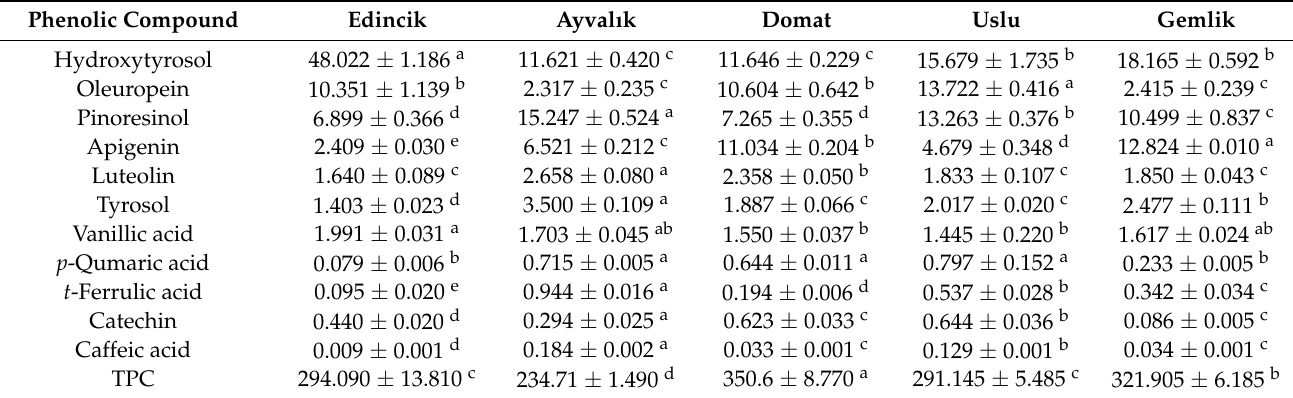
Table 3. Phenolic compounds (mg · kg − 1 ) in EVOOs from five Turkish olive